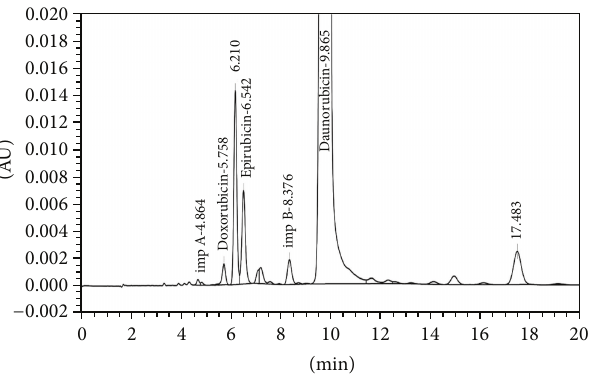
Figure 6: FT-IR spectra of unirradiated and gamma irradiated doxorubicin.